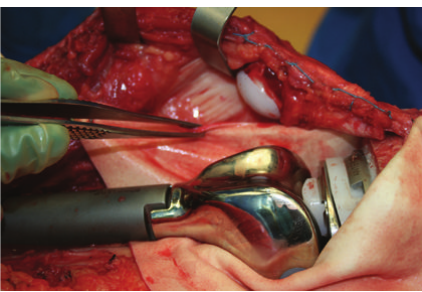
Figure 2: Attachment of alloderm to residual capsule and border of patellar tendon.